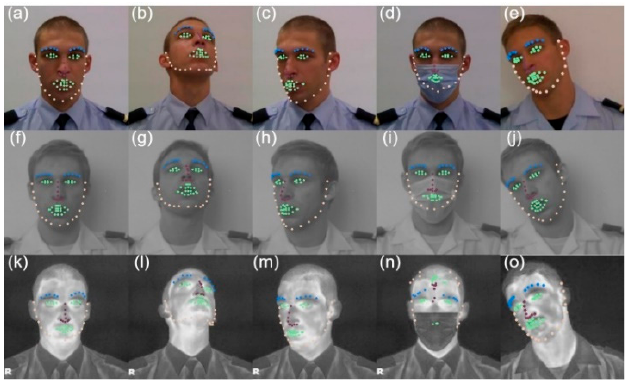
Figure 8. Results achieved by 2D-FAN in the spectral bands of VIS ( a – e ), NIR ( f – j ) and LWIR ( k – o ). Yellow—jawline, green—eyes and mouth, purple—nose, blue—eyebrows.